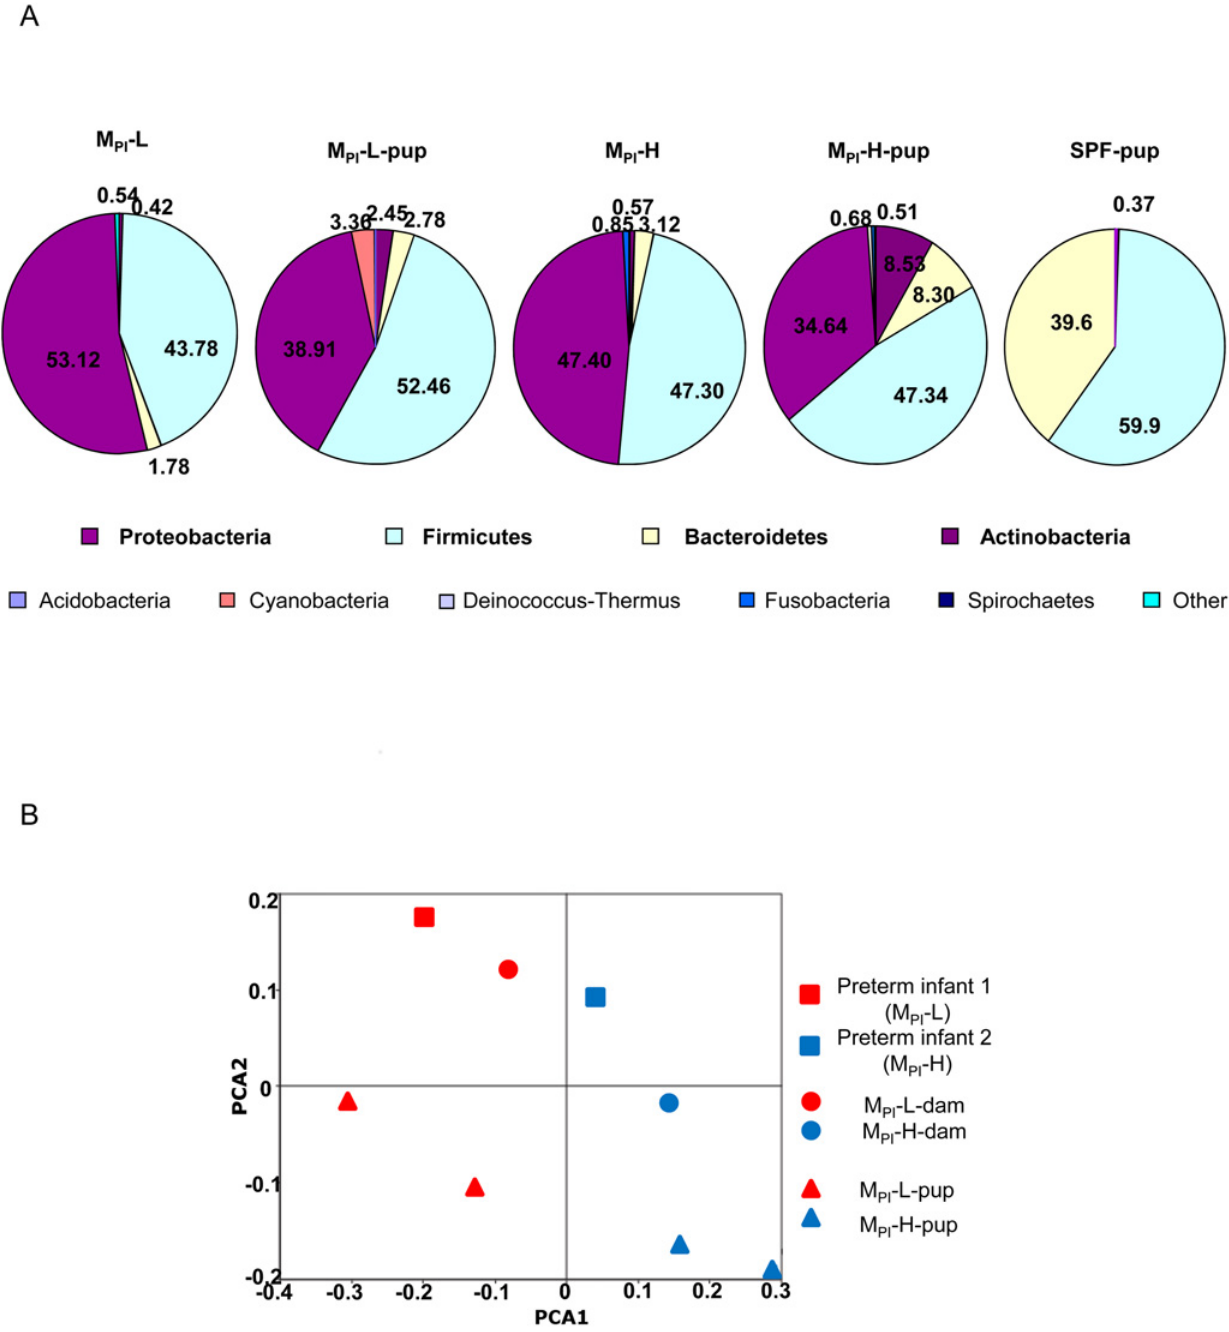
Fig 2. Comparison of bacterial communities following transfaunation of germ free mice with M PI fecal lysates. A: The relative abundance of different bacterial phyla in input M PI -L,-H fecal samples and from M PI -L, H and SPF preweaned mouse pups is shown. B: PCoA analyses of the M PI -L and M PI -H in original human infants, transfaunated dams and respective pups based on Bray Curtis dissimilarities among samples given presence/absence of major taxa present in at least one sample. Axis 1 explained 27.5% of variation and axis 2, 18.1%.